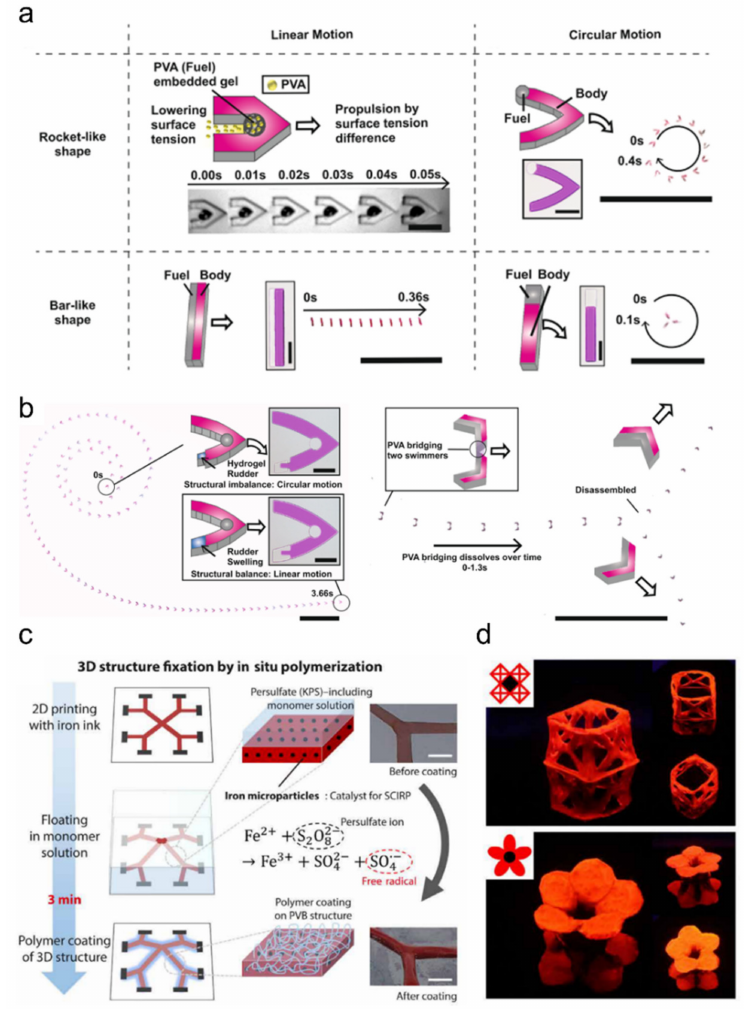
Figure 14. ( a , b ) Schematic and demonstration of programmable Marangoni microswimmers made of PVA-embedded hydrogel. Embedded PVA is used as fuel, which reduces the local surface tension, leading to propulsion without external stimuli; adapted with permission from [173].